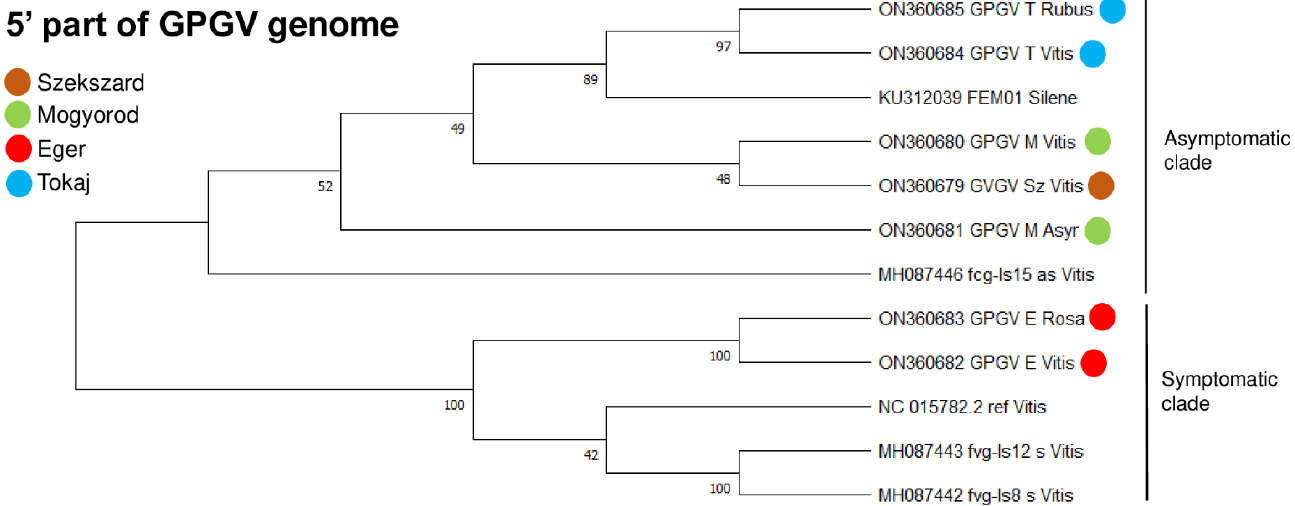
Figure 5 . Evolutionary analysis of 5 ′ nucleotide region of GPGV genome by the maximum likelihood method. Evolutionary history was inferred by using the maximum likelihood method and the Tamura–Nei model. Bootstrap consensus tree inferred from 1000 replicates is taken to represent evolutionary history of analyzed taxa. Branches corresponding to partitions reproduced in less than 50% bootstrap replicates are collapsed. Percentage of replicate trees in which associated taxa clustered in bootstrap test (1000 replicates) is shown next to branches. Evolutionary analyses were conducted in MEGA11. Colored circles indicate geographical origins of strains. HUCSK8as and HUCSK9s are asymptomatic and symptomatic GPGV strains described in Hungary [5]. Ref is GPGV reference genome from grapevine; FEM01 strain was described from Silene [11]. Symptomatic (s) and asymptomatic (as) GPGV isolates Fvg-is-8_s, 12_s, and 15_as were described by Tarquini et al.